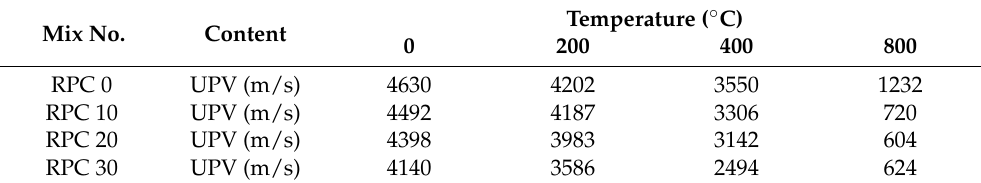
Table 7. UPV value after exposed to high